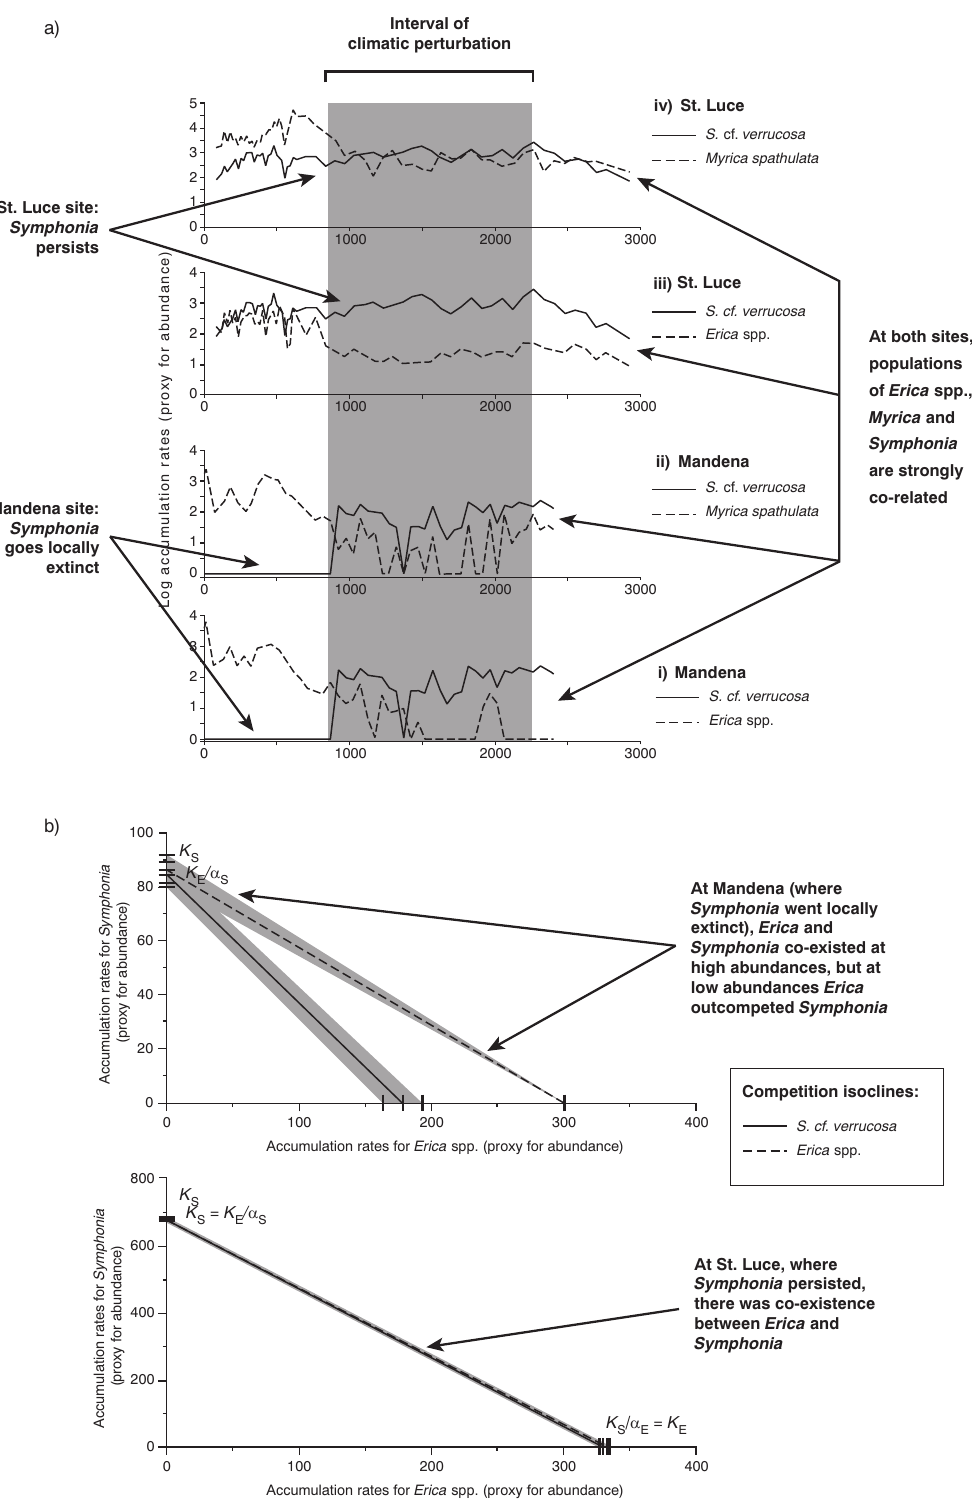
Accumulation rates for Erica spp. (proxy for Fig. 3. (a) Symphonia dynamics in relation to Erica spp. and Myrica in two forest fragments: at fragment (Mandena M15) where it became extinct at 950calyr BP (i,ii) and another fragment (Saint Luce S9) where it persisted (iii,iv). Note that grey bands are periods of marine inundation between 2300 to 800calyrBP accompanied by climatic desiccation around 950calyrBP. (Redrawn from Virah-Swamy et al., 2009a) (b) Models describing Symphonia dynamics (Redrawn from Virah-Swamy et al.,